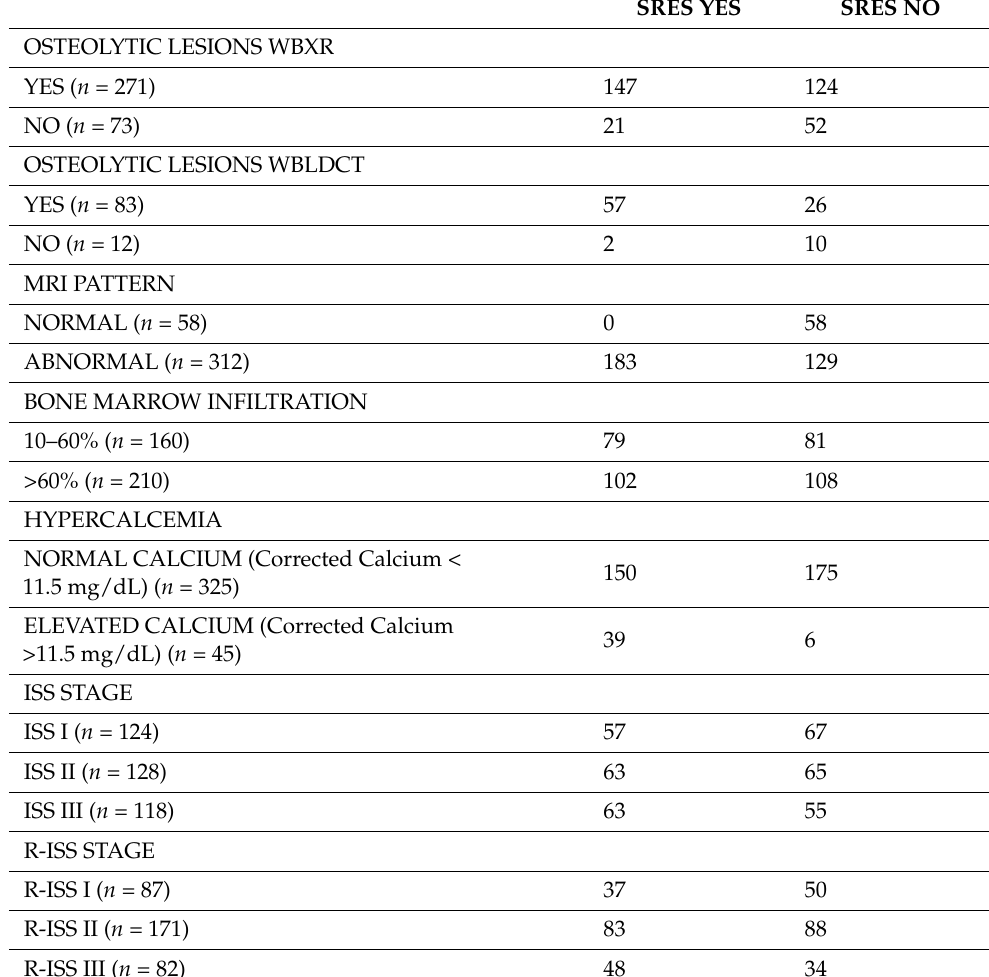
Table 5. Distribution of SREs according to baseline disease